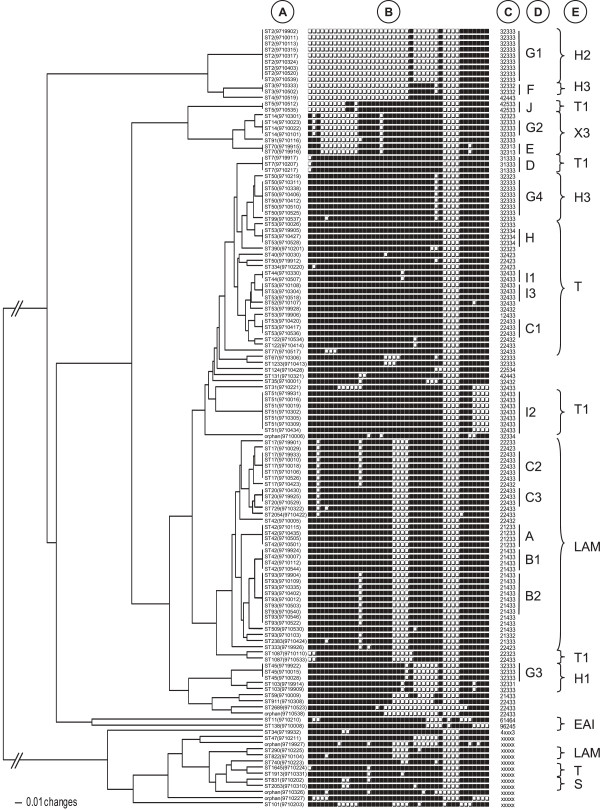
UPGMA dendrogram obtained through a combined numerical analysis of spoligotypes and VNTR profiles of the 129 M. tuberculosis clinical isolates from Guadeloupe. The letters in front of the tree correspond to the following information: A: SIT numbers of the spoligotype profiles with, in brackets, the strain numbers; B: binary spoligotypes; C: 5-loci VNTR profiles. The “x” symbol among a profile indicates a missing or uninterpretable result; D: clusters numbers; E: clades attribution of the spoligotype profiles.